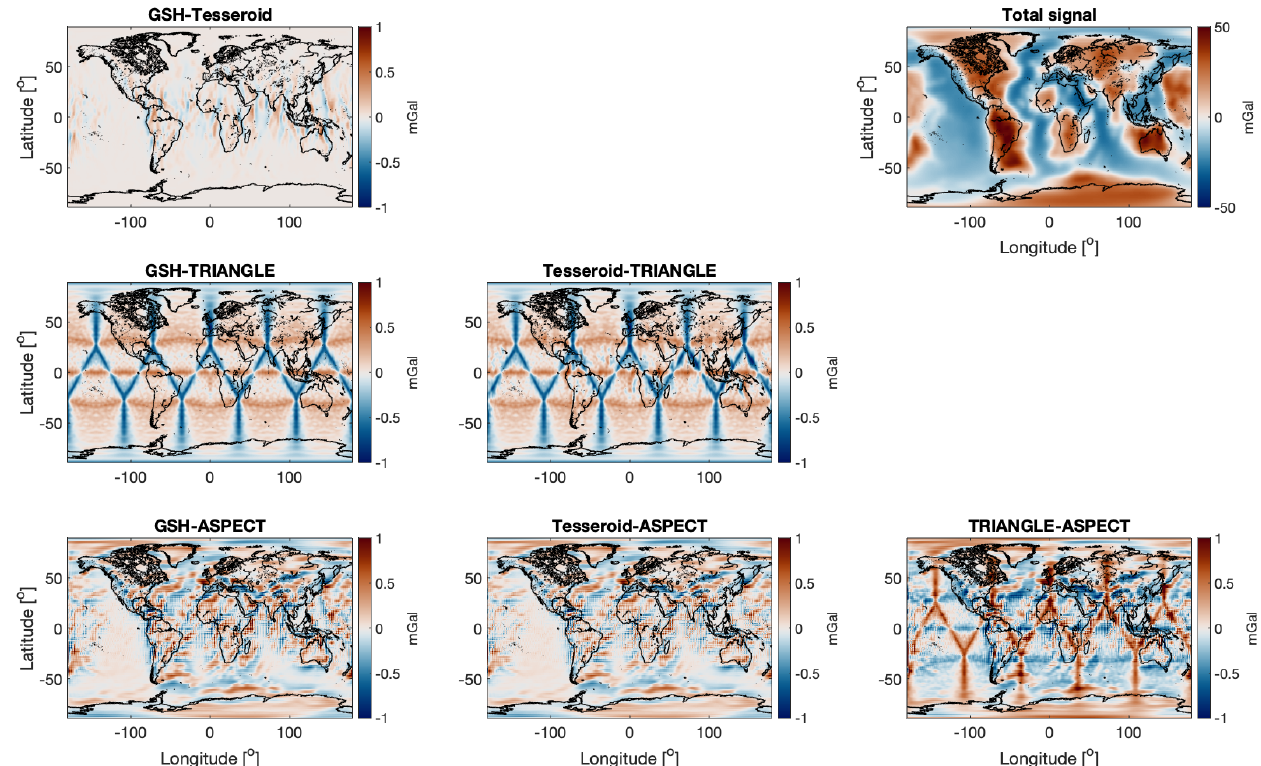
Figure 6. Radial gravity component comparisons at 250km height for shell test 2, wherein a 24km thick shell is modelled with laterally varying density structure. A grid resolution of 1 × 1 equi-arc degree was used for GSH, TESS, and TRI. ASPECT was run on an L7 mesh, i.e. an average lateral resolution of less than a degree.